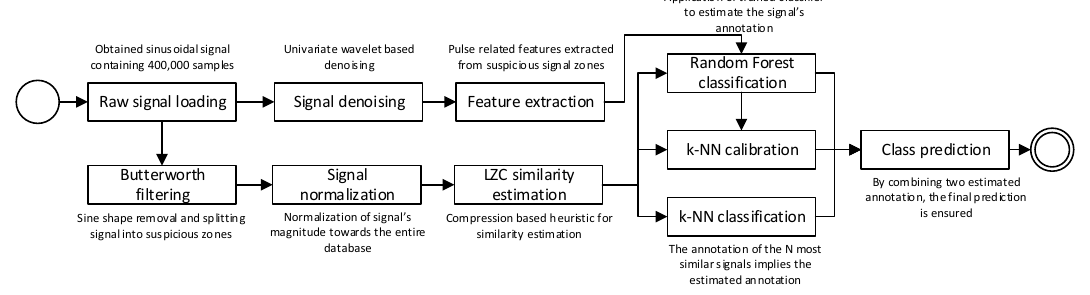
Figure 1. Process diagram of the entire experiment depicting the most important